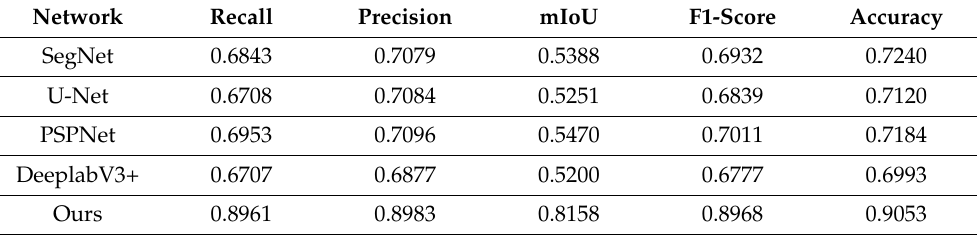
Figure 11. Left to right: input RGB image, ground truth of semantic segmentation, prediction results of our proposed network, and prediction results of SegNet, U-Net, PSPNet, and DeepLabV3+. The results show that extant networks are more sensitive to the color information of input images and demonstrate the robustness of our proposed network to photo information. Table 2. Comparison of evaluation metric results between current networks and our proposed network. The results demonstrate that our network outperforms other networks in all metrics.